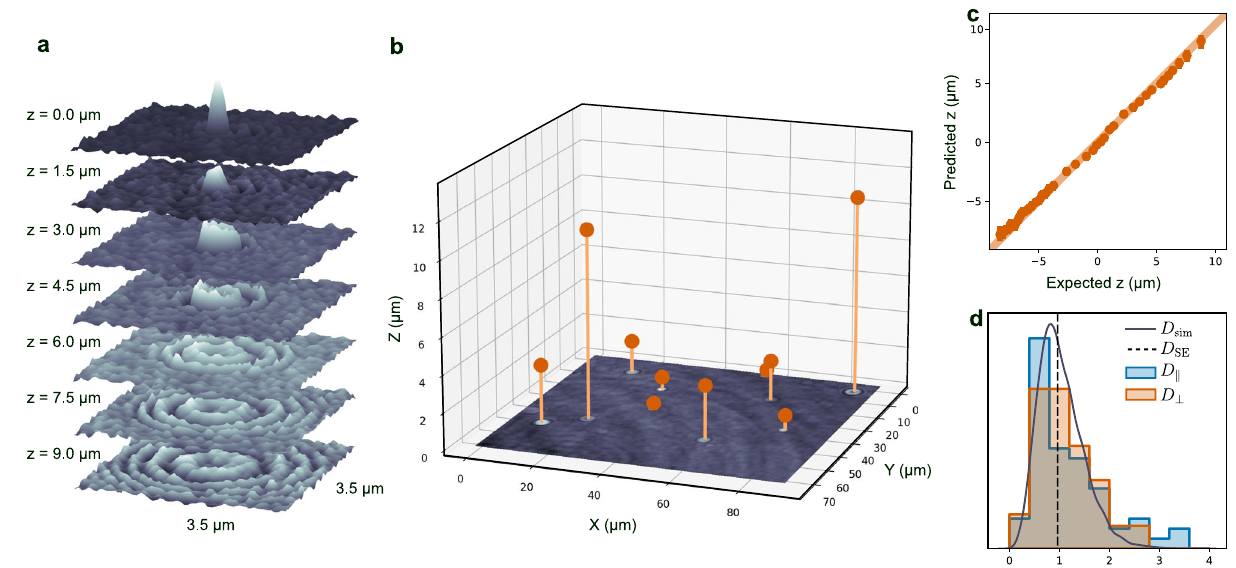
Fig. 4 | LodeSTAR measurement of 3D positions exploiting Fourier propaga- tion symmetry. a Imaginary part of the hologram of a 228nm radius polystyrene particle numerically Fourier-propagated to different axial distances from the focal plane. b LodeSTAR exploits this Fourier propagation symmetry to learn how to locate particles in three dimensions (orange positions). c The vertical position estimated by LodeSTAR agrees well with the expected position acquired using a